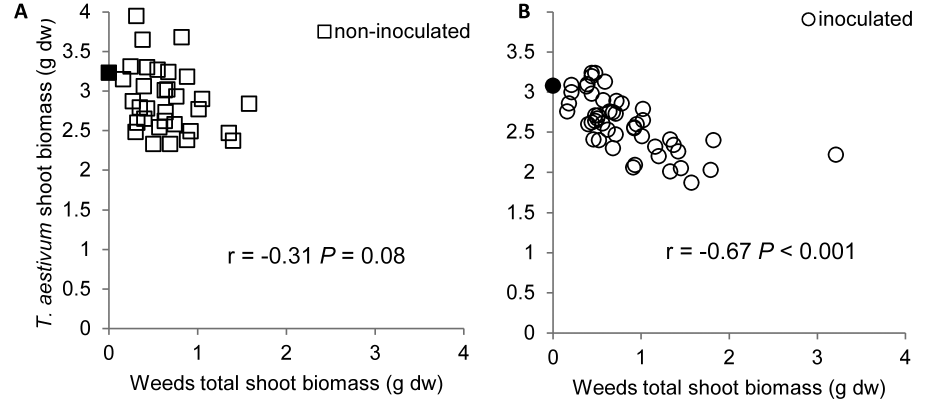
Figure 3. Correlation between crop and weeds depend on soil inoculation. Correlation between T. aestivum shoot biomass and weeds shoot biomass within the same pot on sterilized A non-inoculated soil and B inoculated soil in the feedback phase. Spearman rank correlation coefficients and P -values are shown in the graphs. Filled symbols indicate the average T. aestivum shoot biomass in the absence of weeds; n=32 for non-inoculated soils and n=48 for inoculated soils.